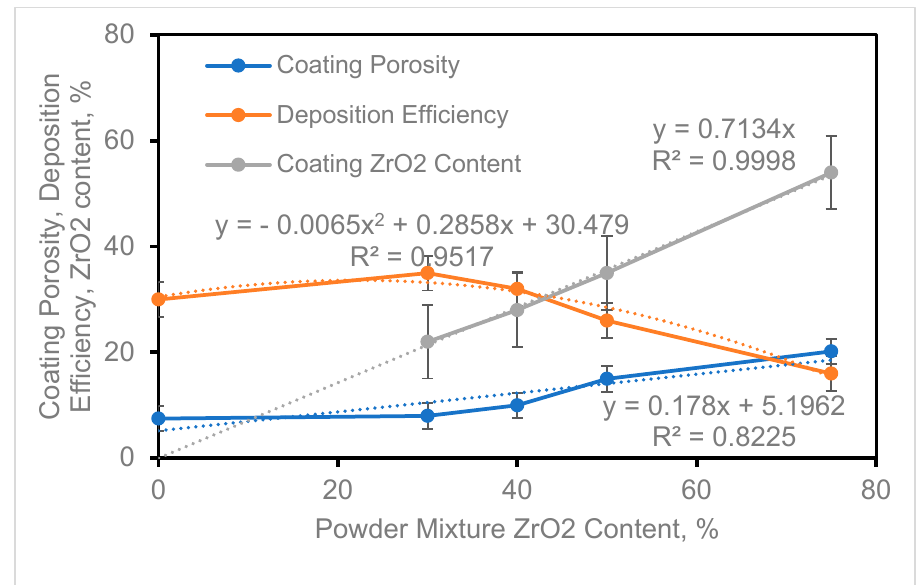
Figure 7. Al-ZrO 2 coating characterization. Approximation curves are shown by dotted lines.